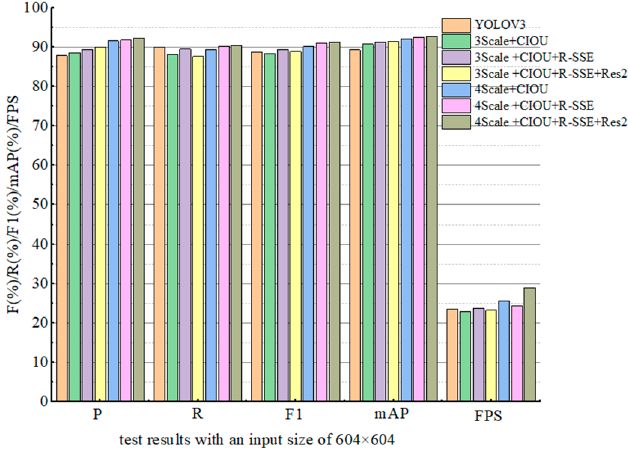
Figure 5. Histogram of test results with an input size of 604 × 604.